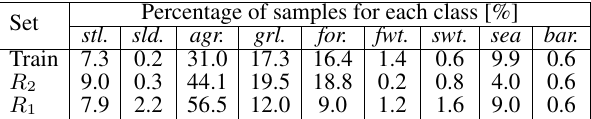
Table 1. Class label distribution for the training and test datasets